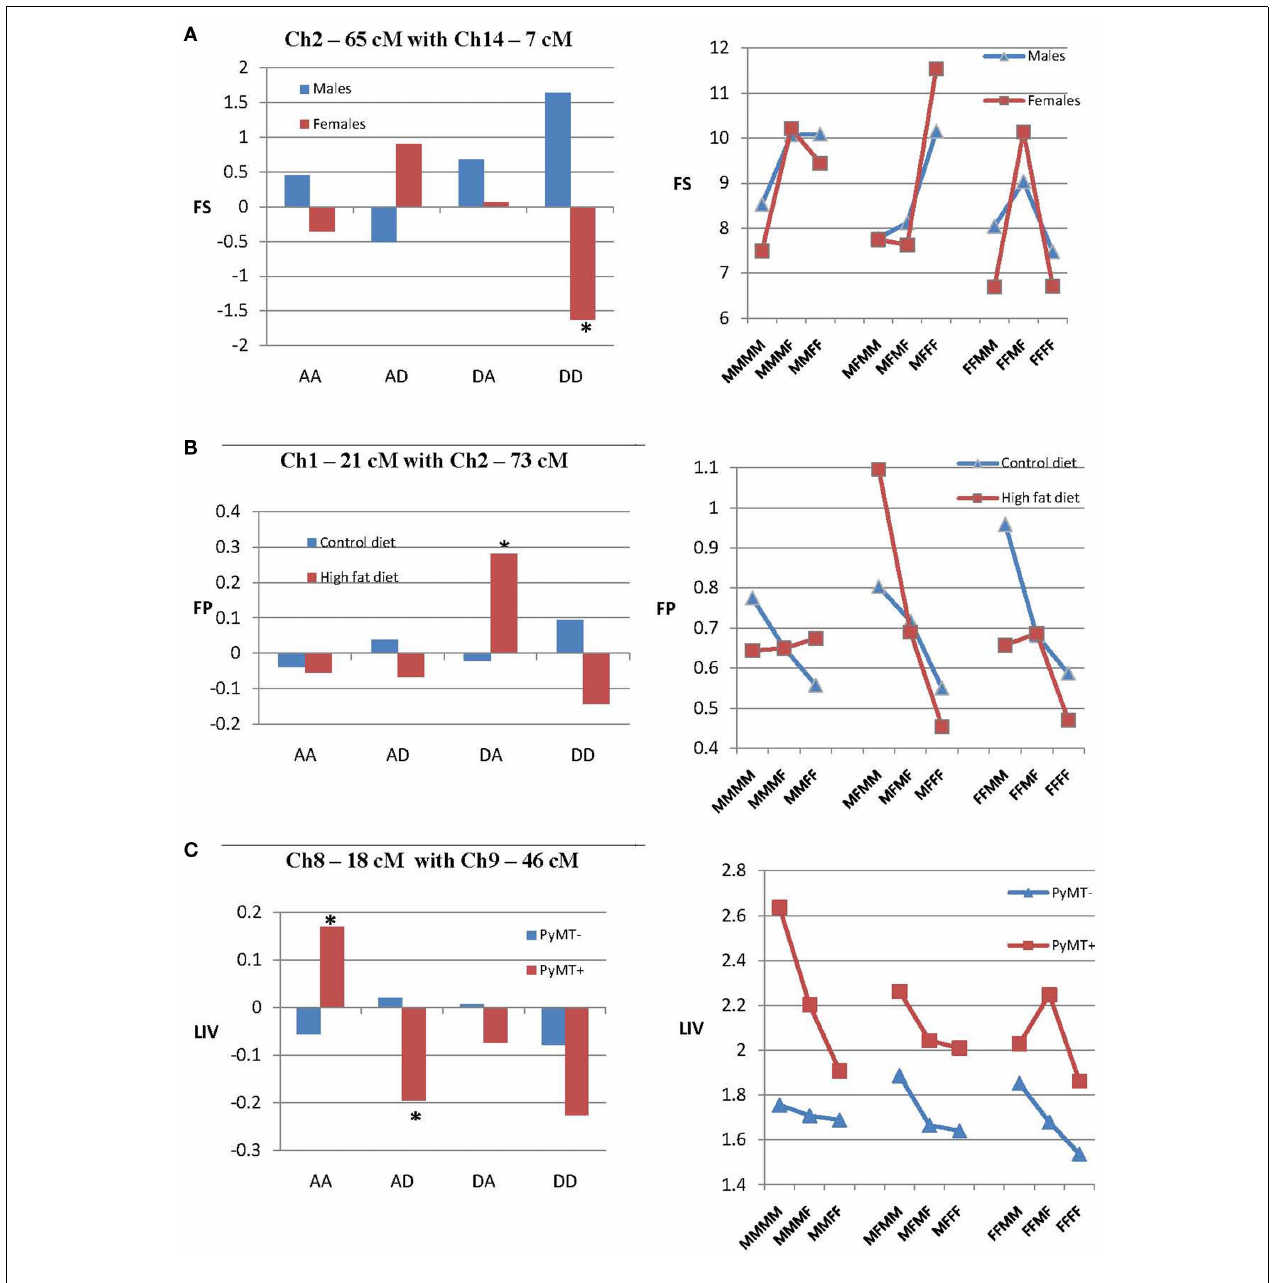
of the two QTLs. (A) Illustrates dd epistatic effects of QTLs on chromosomes 10 and 13 on 6W that are significant only in males. (B) Illustrates epistatic effects of chromosome 2 and 3 on FP that are significant only in mice fed the high-fat diet. (C) Illustrates epistatic effects of chromosomes 3 and 9 on FS that are significant only in mice with the PyMT